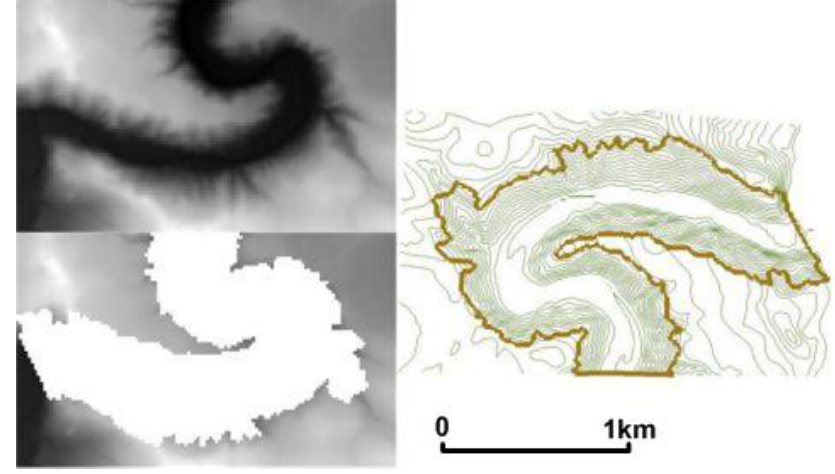
Figure 9. The second DTM (16 m resolution) used for testing (up left) and with draped extraction results (down left – white area). The boundary of the extracted canyon superimposed on the contour map with the equidistance of 10 m